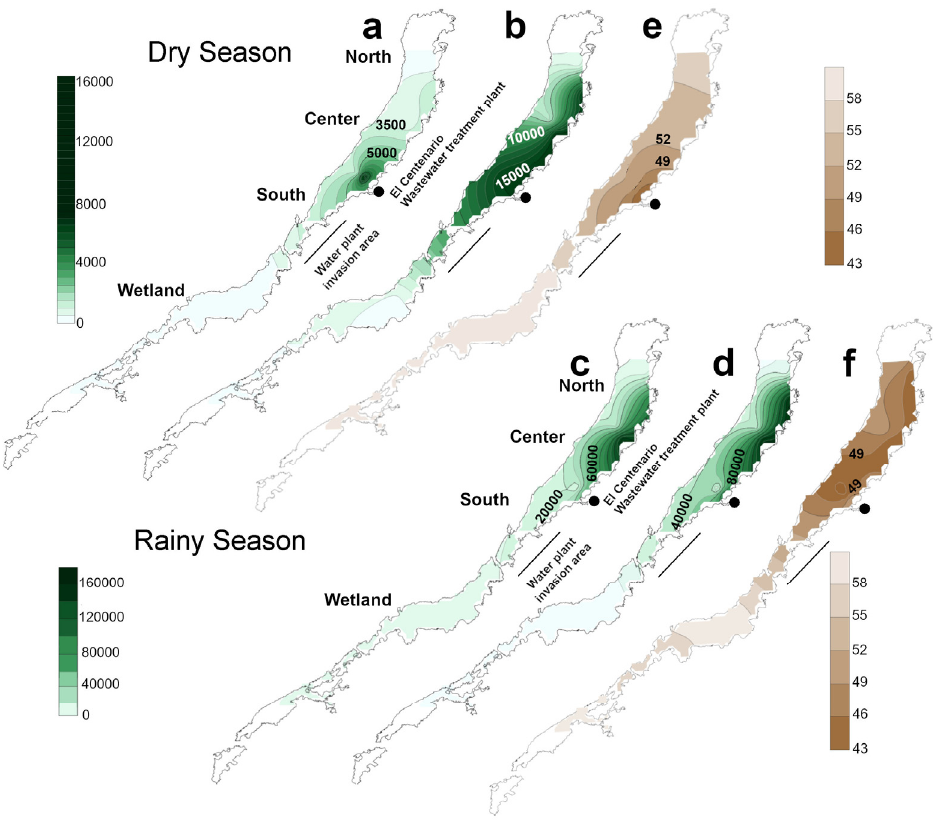
Figure 2. Interpolated map of fecal and total coliform content and water quality of Lake La Sabana during two climatic periods. Dry season: ( a ) fecal coliform content in surficial waters; ( b ) total coliform content in surficial waters; ( e ) National Sanitation Foundation (NSF) water quality index. Rainy season: ( c ) fecal coliform content of surficial waters; ( d ) total coliform content of surficial waters; ( f ) NSF water quality index.